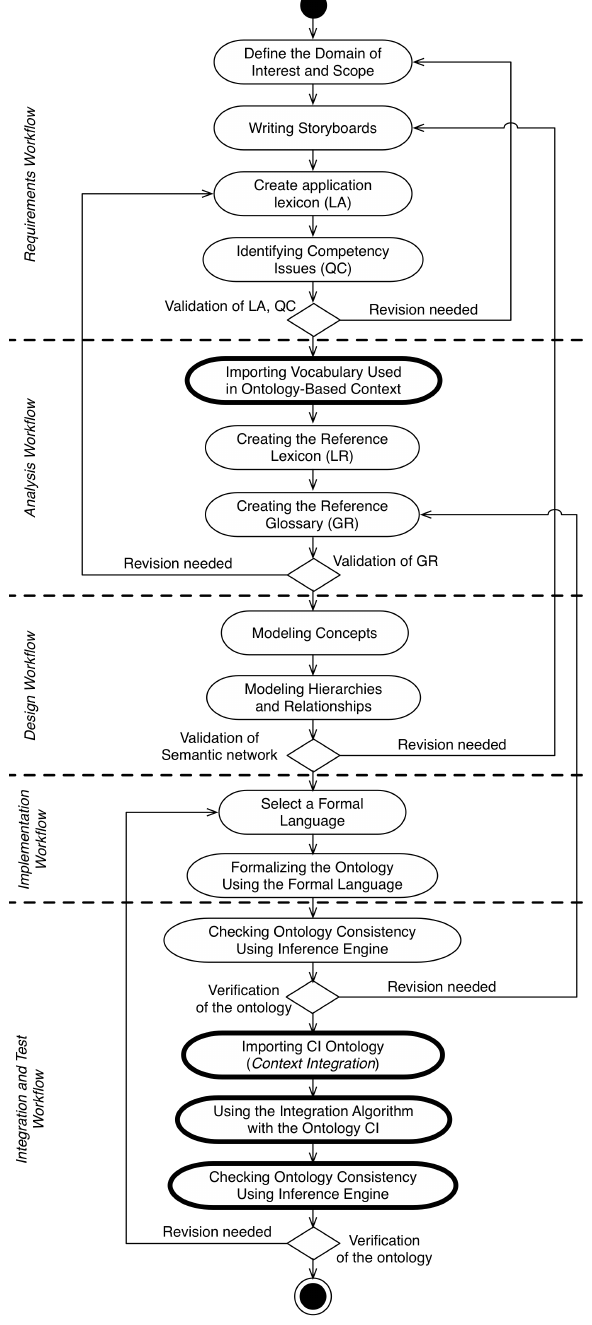
Figure 5. Overview of Context